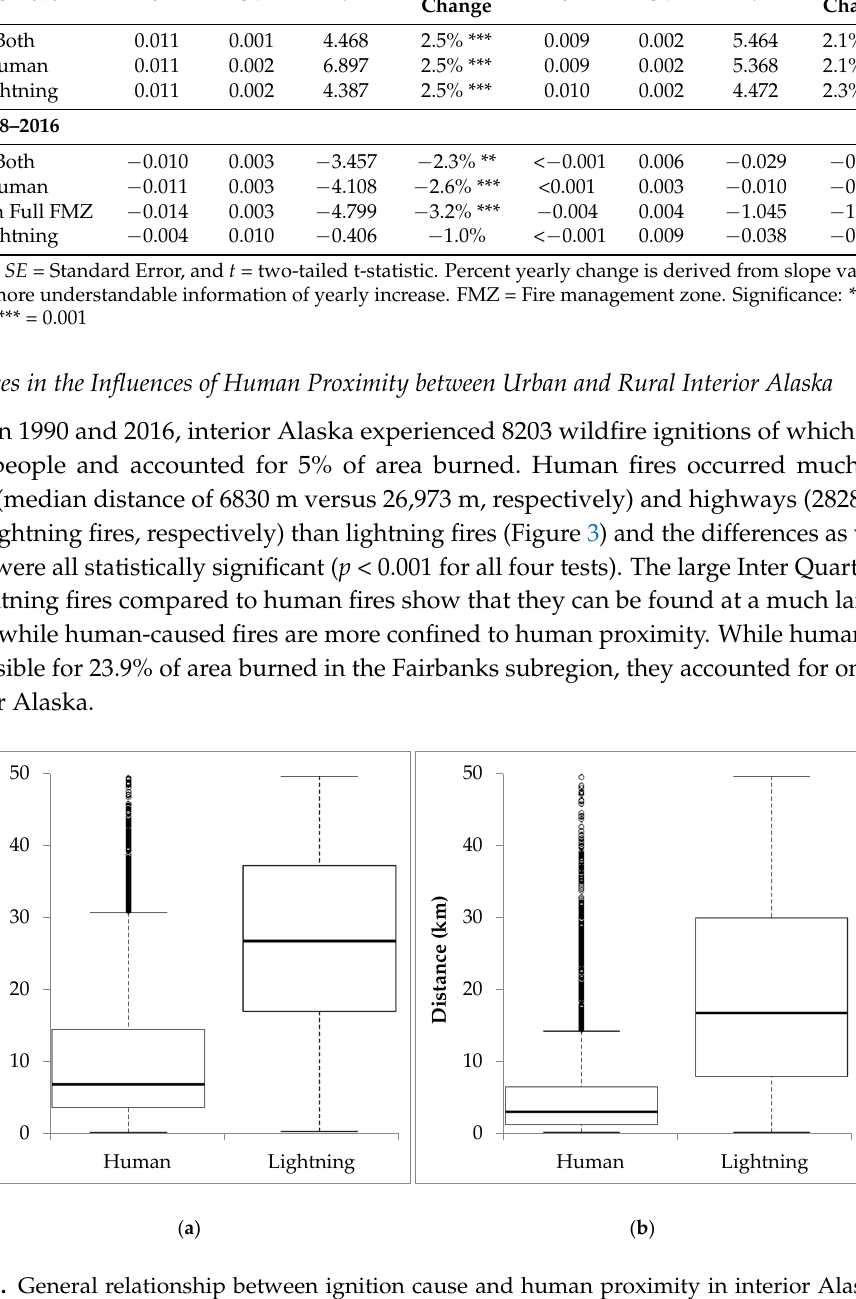
Table 2. Log-linear regression results on temporal trends in fire ignitions using log 10 (annual ignitions) in the Fairbanks subregion versus rural interior Alaska. Fairbanks Rural Int. AK